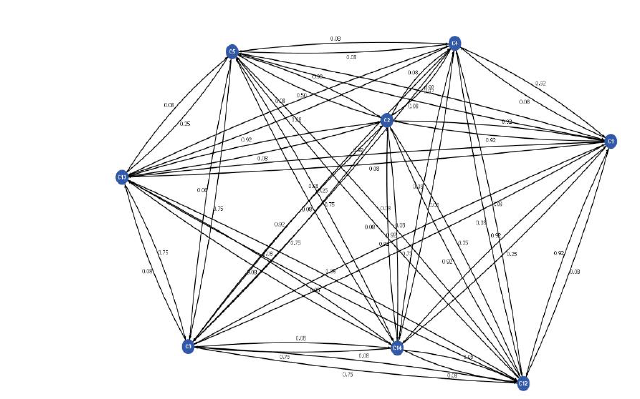
Fig. 7. Graphical representation of P&H factors of FCM.